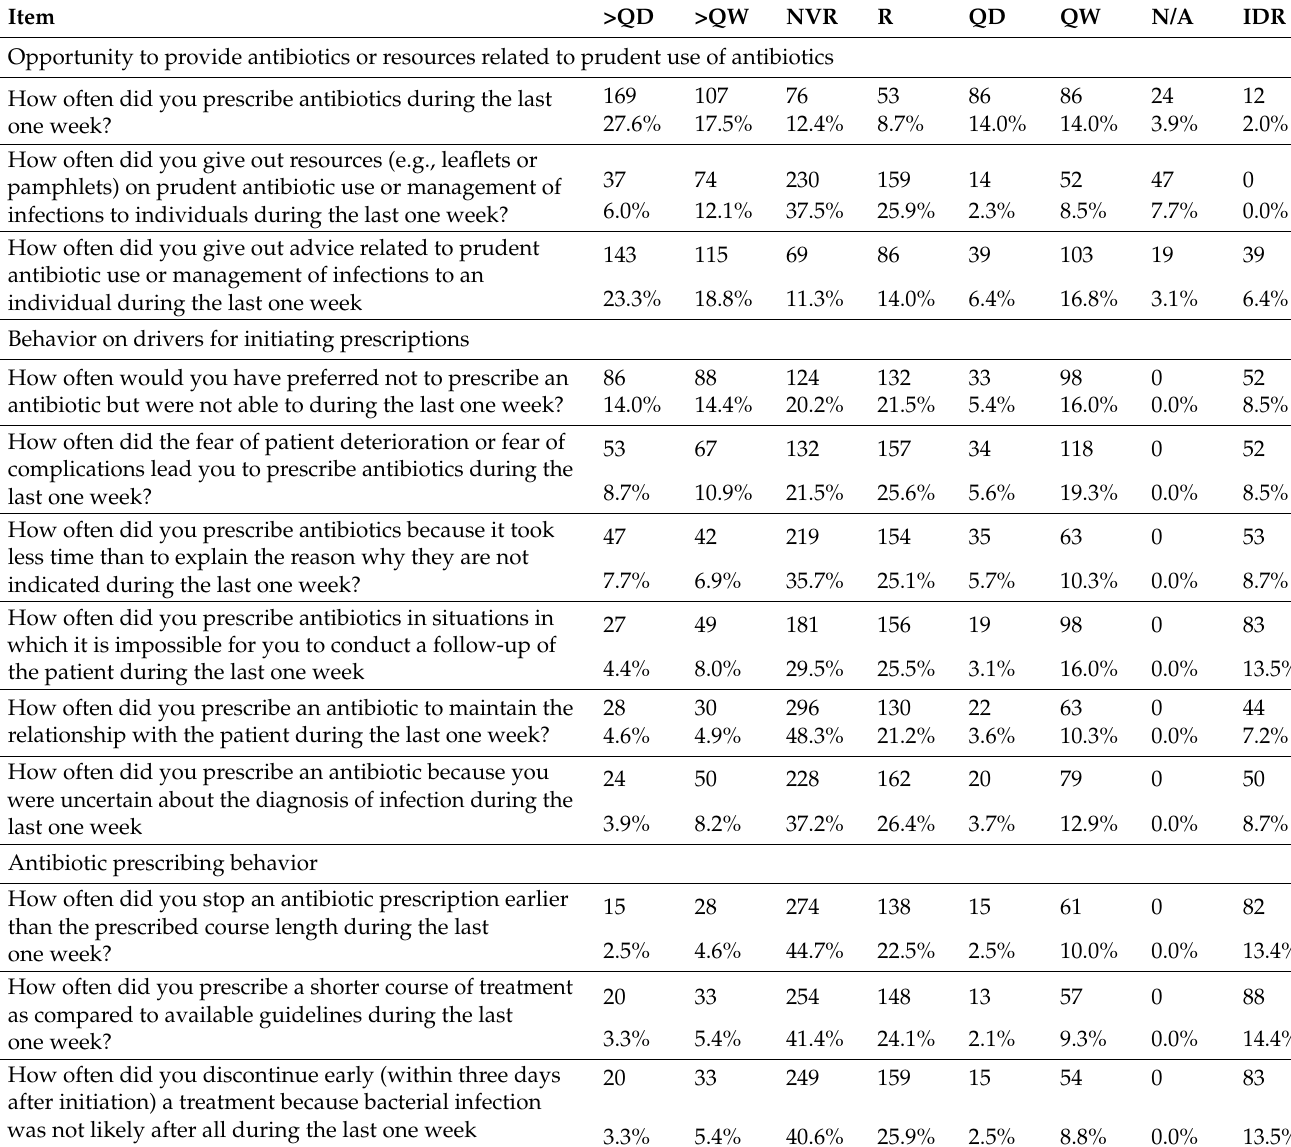
Table 6. The frequency with which prescribers provided antibiotics or resources related to prudent use of antibiotics, behavior on drivers for initiating prescriptions and antibiotic prescribing